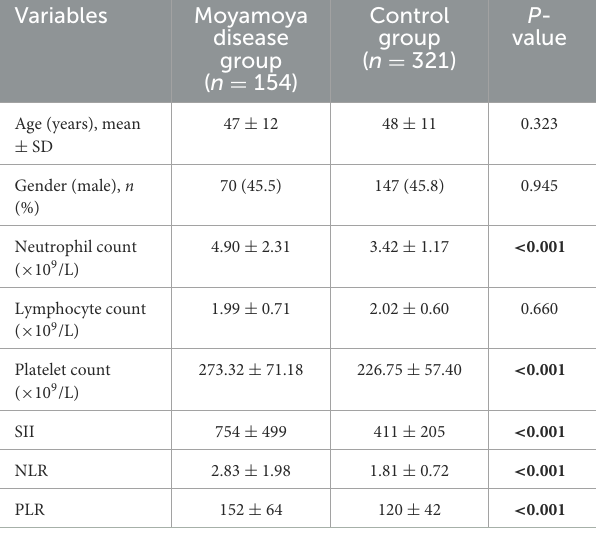
TABLE 1 Comparison of demographic features and clinical characteristics between the study and control groups.